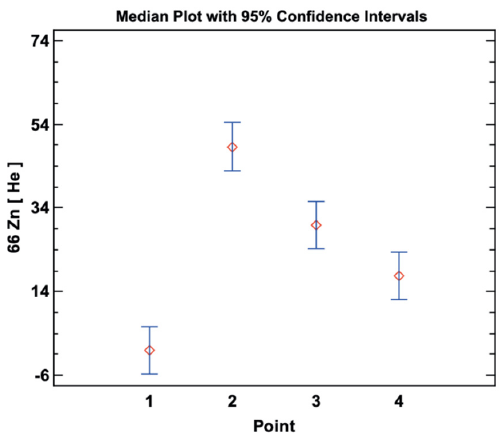
Figure 7. Graph of means with LSD Fisher intervals at 95% confidence, for the effect of the sample collection point with the concentration of Zinc (Zn).